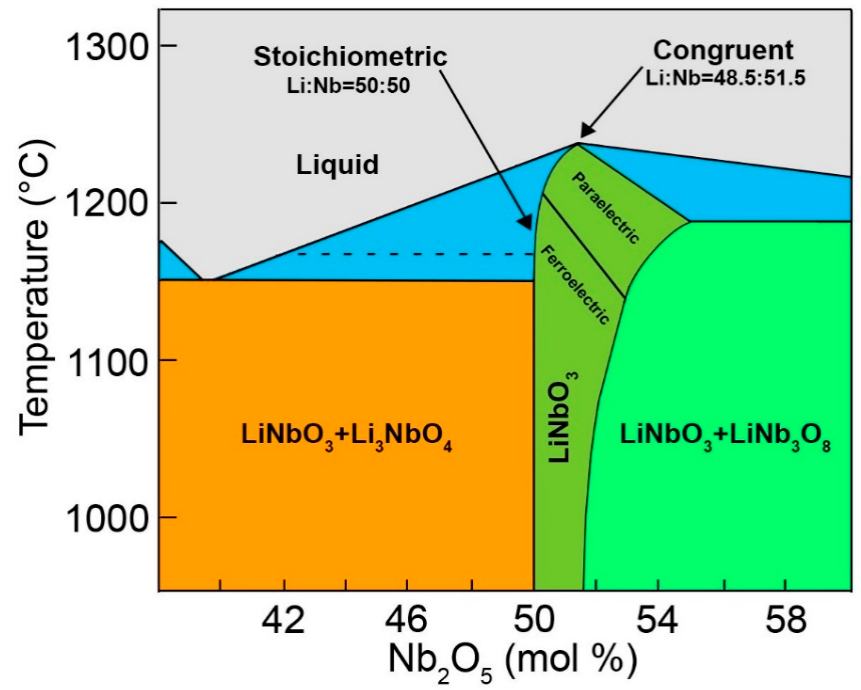
Figure 1. Schematic phase diagram of the Li 2 O—Nb 2 O 5 pseudobinary system in the vicinity of LiNbO 3 .